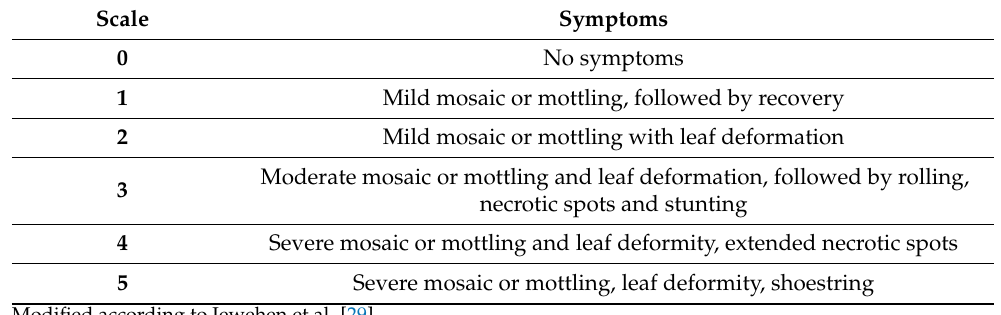
Table 1. Symptom severity scale on inoculated pepper